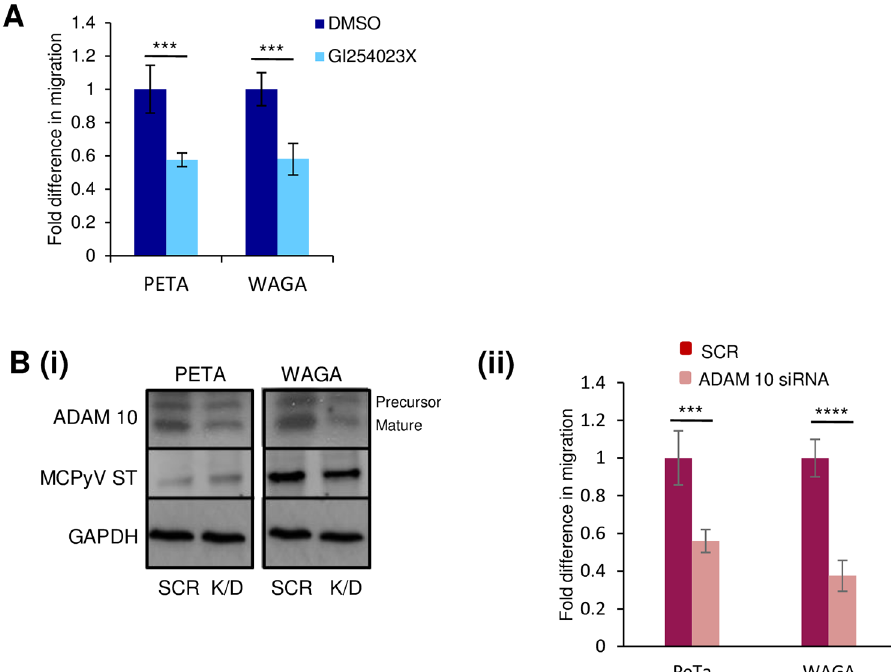
Fig 8. ADAM 10 is required for the motility of MCC cells. (A) MCPyV positive MCC cell lines, PeTa and WAGA, were incubated with DMSO or the ADAM 10 specific inhibitor, GI254023X (50 μ M). Cells were then transferred into migration wells and allowed to migrate from serum-free to 10% FBS conditions for 24 hours. Migratory cells were stained and measured at 560 nm to quantify migration. Average cell migration was calculated and significance tested using a two-tailed Student’s t-test (n = 3), (cid:3)(cid:3)(cid:3) = p < 0.001. (B) (i) PeTa and WAGA cells were transfected with either scramble or ADAM 10-specific siRNAs and cell lysates probed to confirm successful knockdown with an ADAM 10-specific antibody. GAPDH was used as loading control. 2T2 was used to probe for MCPyV ST expression. (ii) Control and ADAM 10-depleted cells were then transferred into migration wells and allowed to migrate from serum- free to 10% FBS conditions for 24 hours. Migratory cells were stained and measured at 560 nm to quantify migration. Average cell migration was calculated and significance tested using a two-tailed Student’s t-test (n = 3), (cid:3)(cid:3)(cid:3)(cid:3) = p < 0.0001, (cid:3)(cid:3)(cid:3) = p <